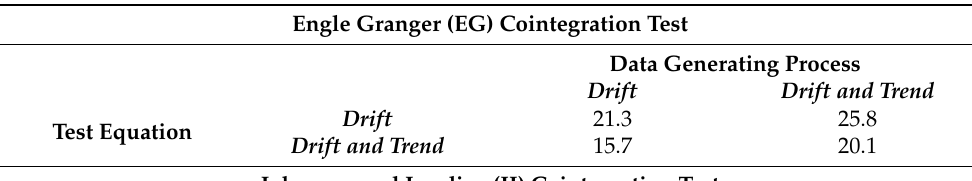
Table 3. Probability of spurious regression with Engle and Granger, Johansen and Juselius cointegra- tion tests, and the Ghouse